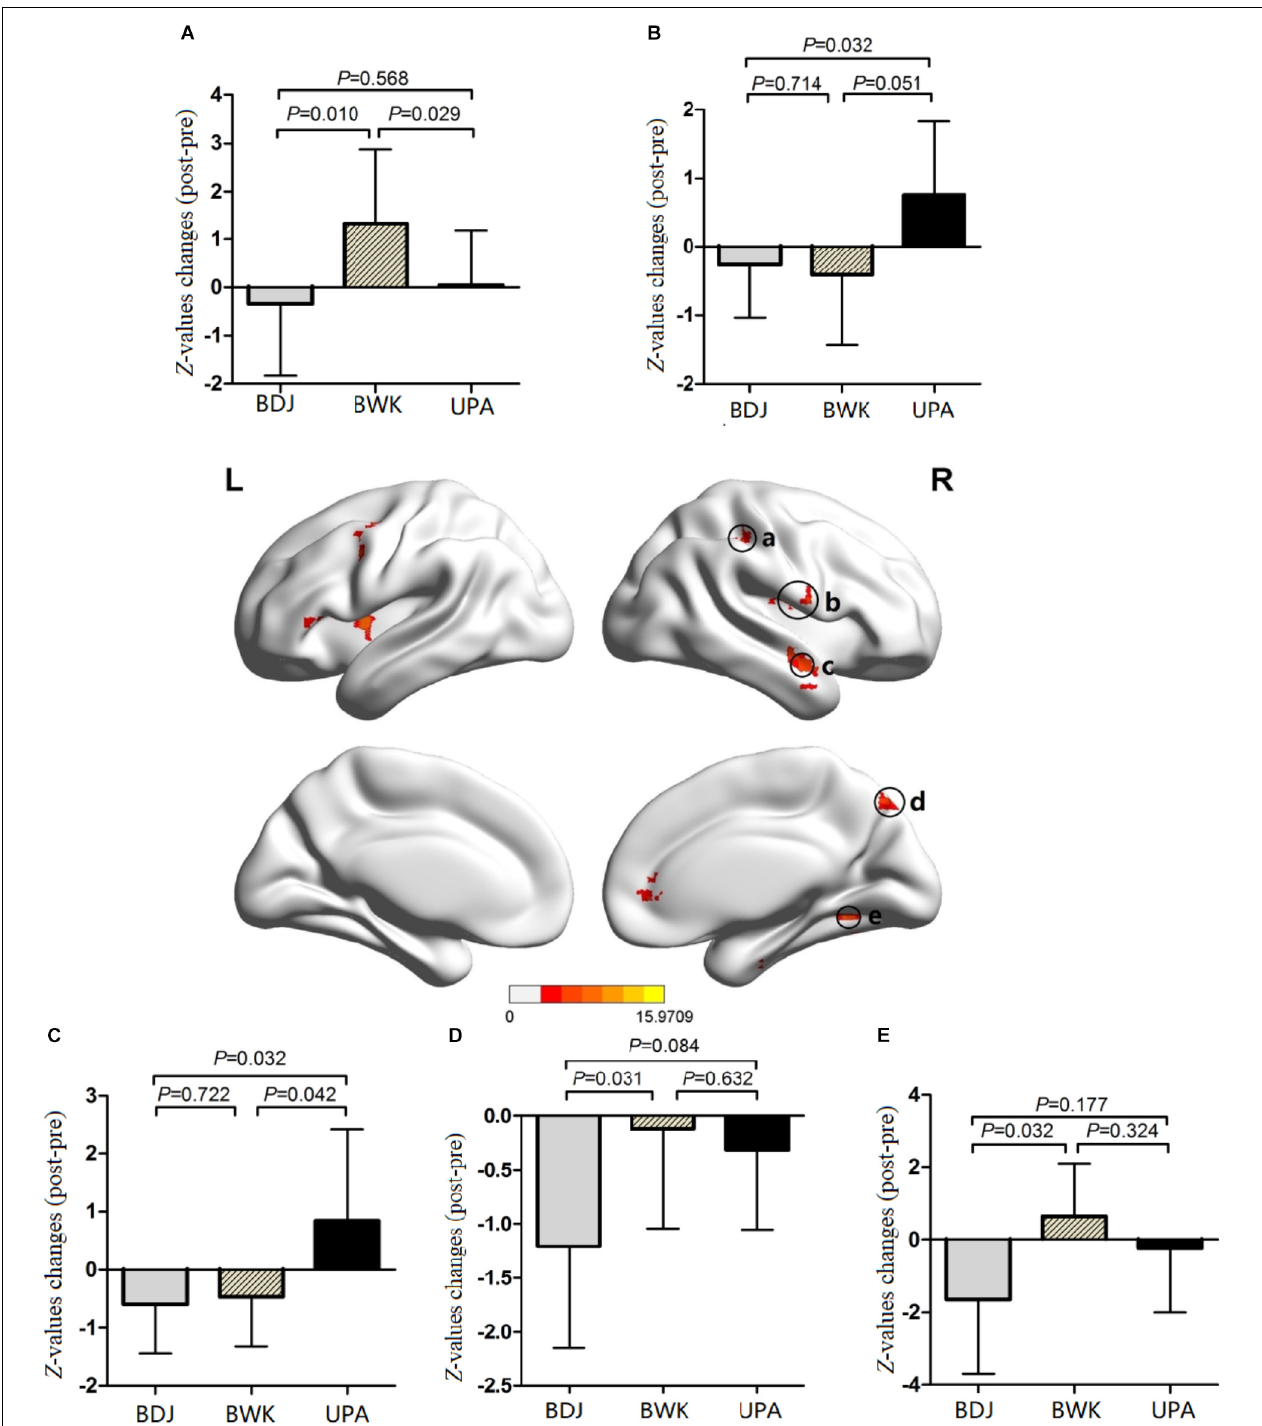
FIGURE 1 | One-way ANOVA and post hoc analysis results of DAN. One-way ANOVA showed that, after the 24-week exercise, there were significant difference at five regions in DAN (cluster-corrected at Alphasim P < 0.05; voxels P < 0.01): IPL.R(a), ROL.R(b), MTG.R(c), PCUN.R(d), and FFG.R(e). Post hoc analysis results are shown, compared to the brisk walking (BWK) group or usual physical activity (UAP) group, in these five regions in Baduanjin group had obvious negative activation, and all the Z -values changes were lower than other two groups. (A) The Z -values changes of BWK group appeared a positive change, significantly higher than the other two groups. (B) There were significant negative changes in Baduanjin group than UAP group. (C) The Z -values changes of UAP group appeared a positive change, significantly higher than the other two groups. (D) The negative changes were occurred across three groups, and there was significant difference between Baduanjin group and BWK group. (E) The Z -values changes of BWK group appeared a positive change, significantly higher than the Baduanjin